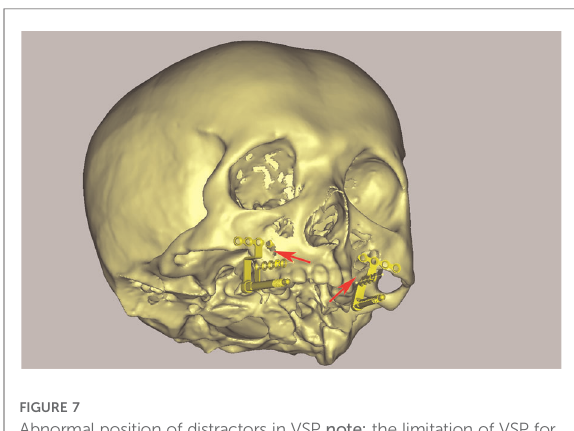
shown on the hologram. The post-operative CT scan con fi rmed that the actual osteotomy plane was in line with the pre- operative plan (11); however, few studies focused on the role